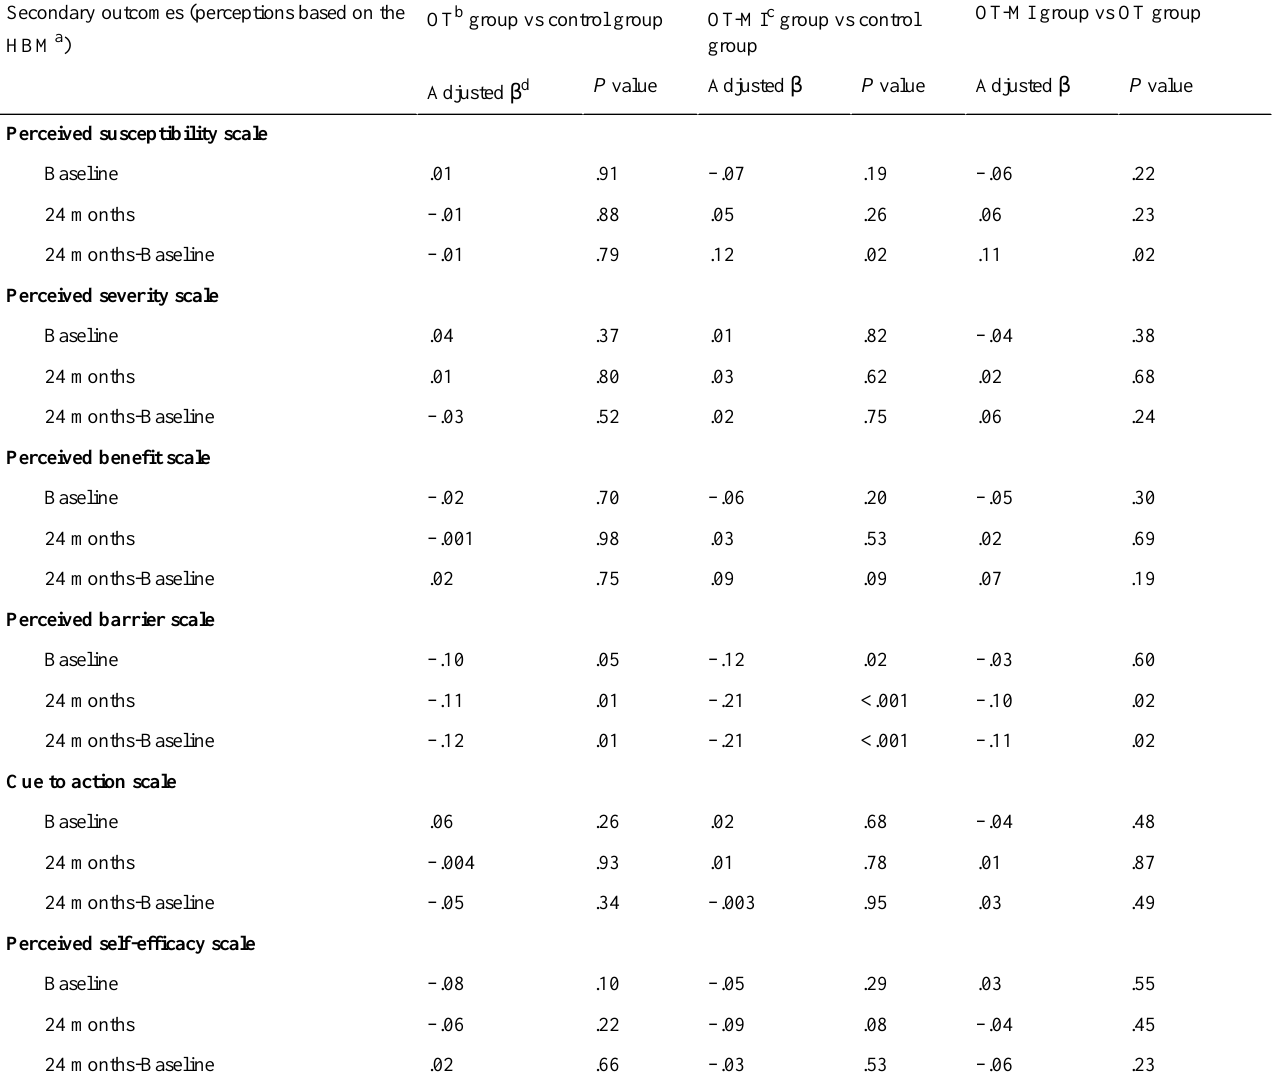
Table 2. Between-group comparisons of secondary